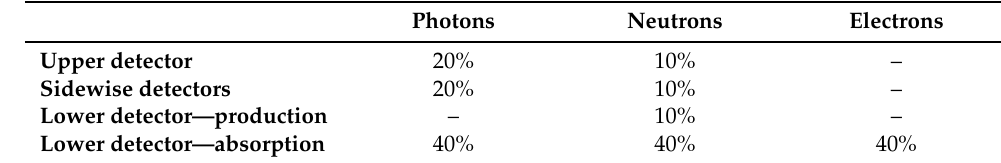
Table 3. The parameter set with the noise thresholds t min optimized for lead.